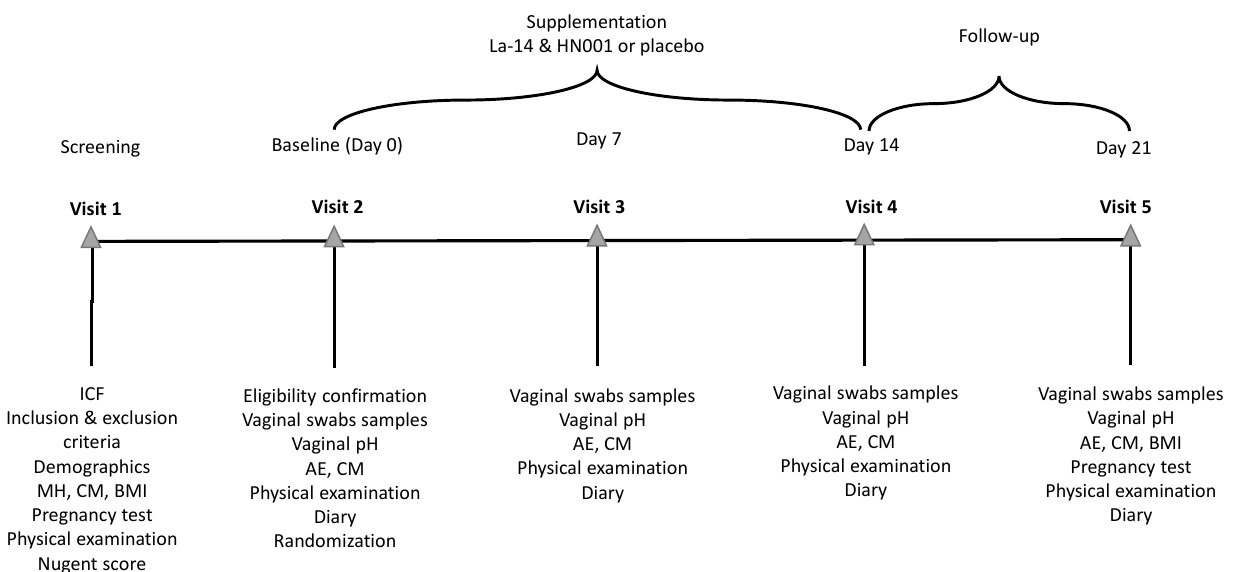
Figure 1. Schedule of events in the study. The screening visit (Visit 1) was held 3 to 42 days before randomisation (Visit 2) to allow for the study endpoints to be measured in between menses. Vaginal pH was measured, and vaginal swabs samples were collected for analysis of vaginal